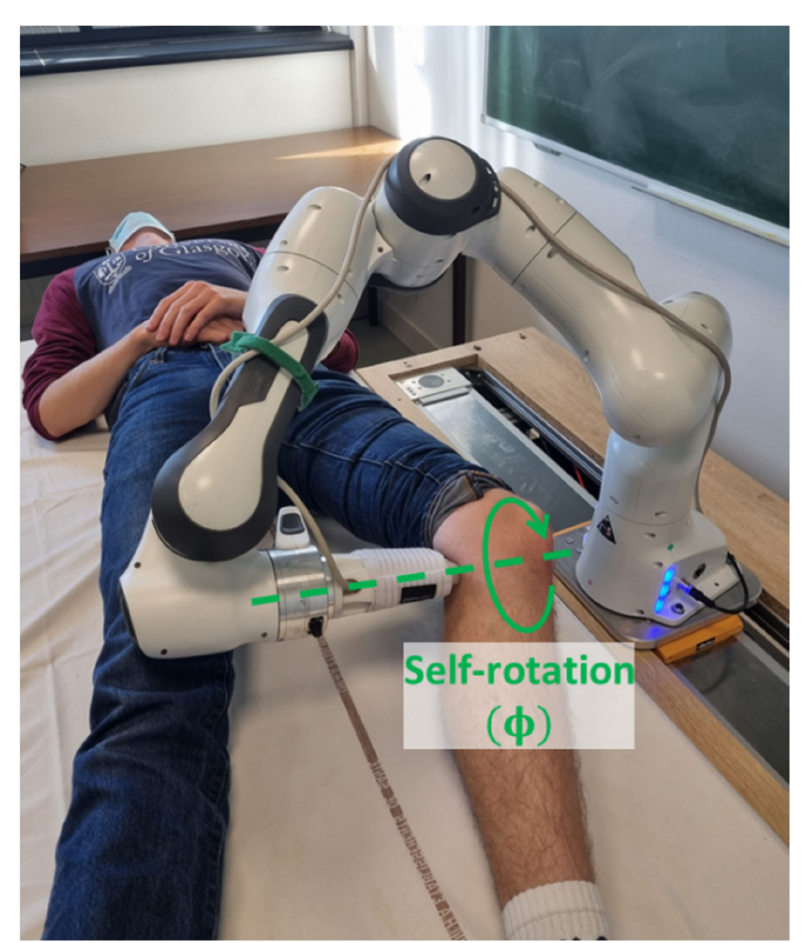
Figure 16. Exemplary image of the study case (no human subjects participated to the experiments). A self-rotation motion is imposed to the haptic probe during a Doppler ultrasound exam (see the accompanying Video S1).